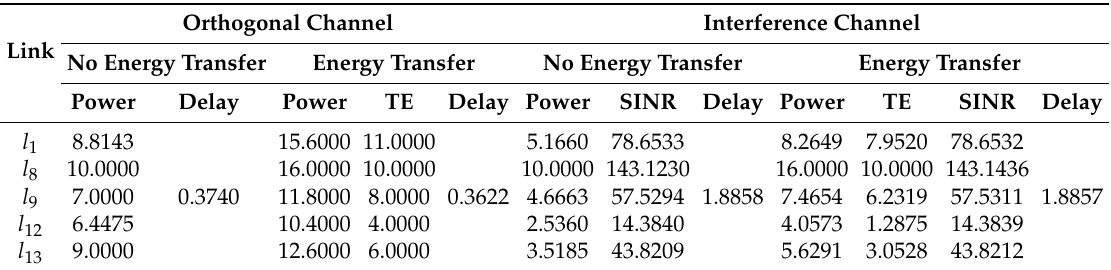
Table 1. Solution results of optimization problem under both orthogonal channel and interference channel in the first time